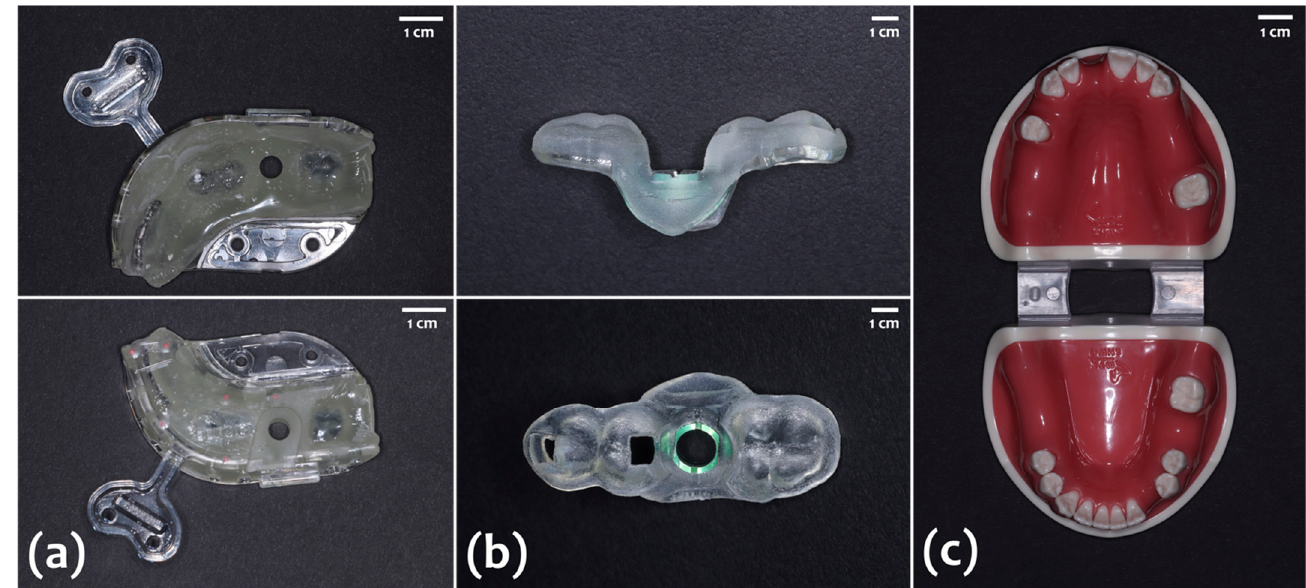
Figure 1. ( a ) VARO Guide ® . ( b ) Navi Guide ® . ( c ) The photograph of the dentiform model used in this